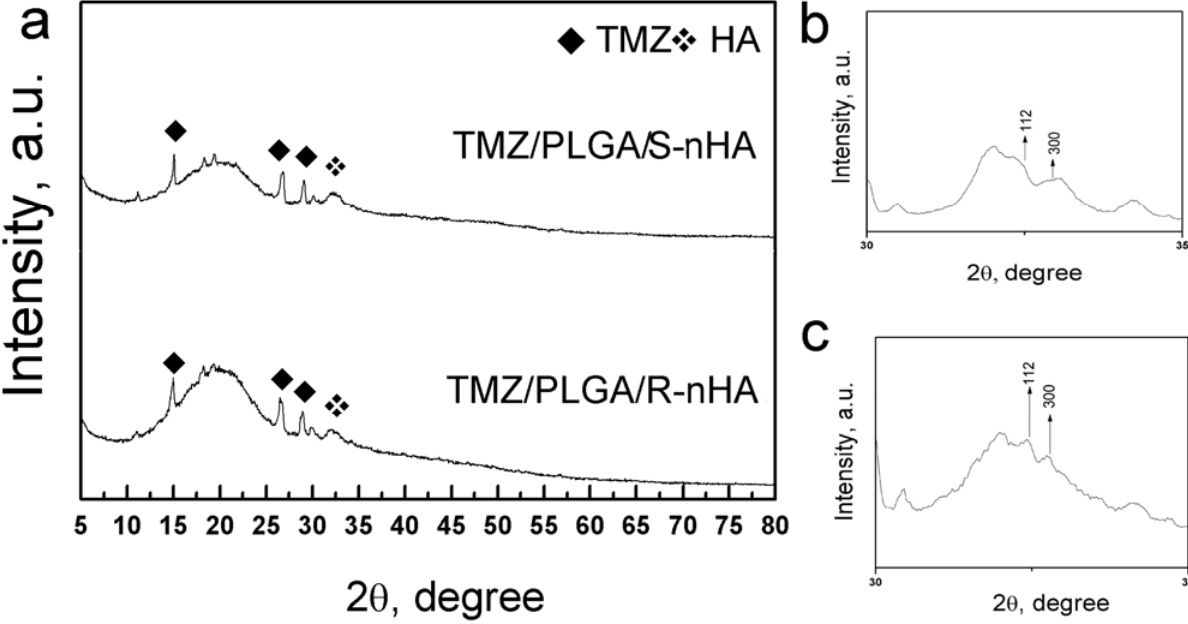
Figure 3. ( a ) The X-ray patterns of TMZ/PLGA/nHA microspheres; ( b ) X-ray patterns of TMZ/PLGA/S-nHA at the HA characteristic peaks; ( c ) X-ray patterns of TMZ/PLGA/ R-nHA at the HA characteristic peaks.